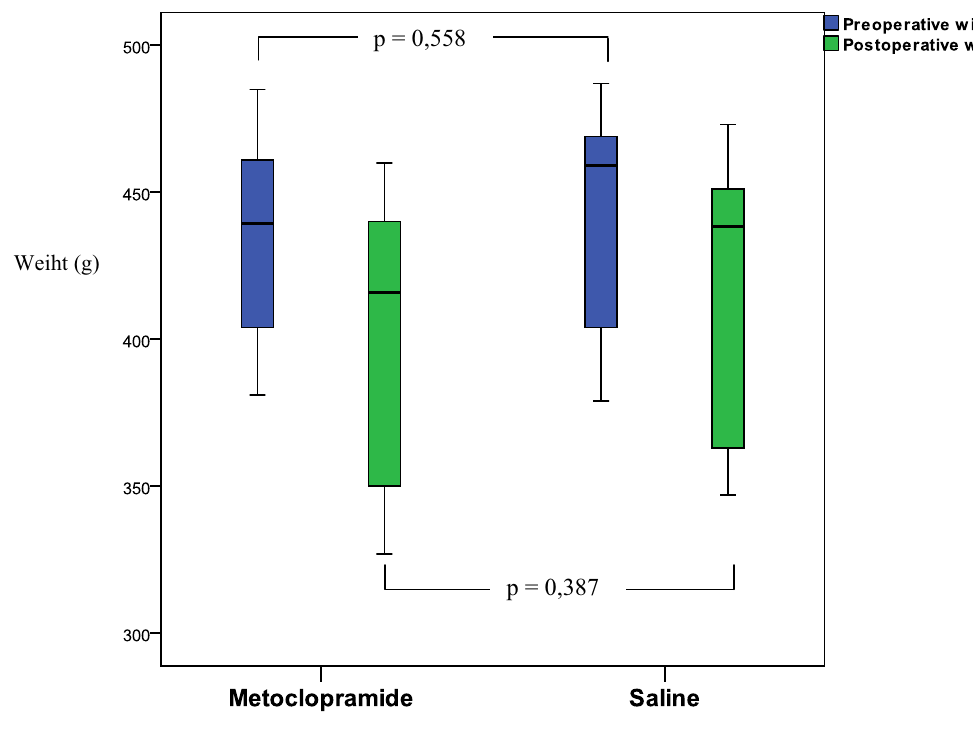
FIGURE 1- Weight of animals euthanized on the 3 rd postoperative day